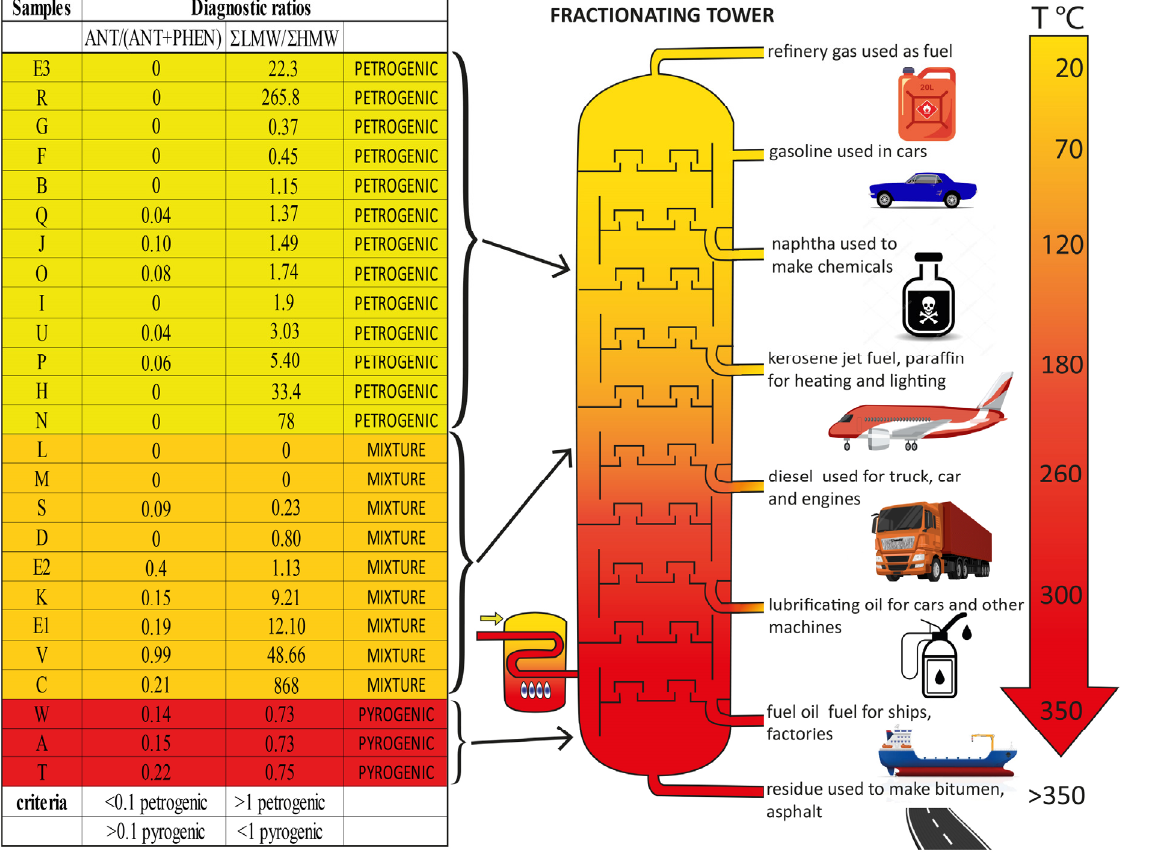
Figure 2. Fractionating tower of different petroleum products. On the left, a table shows, according to the samples, the petrogenic or pyrogenic ratio of the mixture found in the petroleum residues in formulants of pesticides in this study. The origin in the fractionating tower is indicated on the right, highlighting that the ratio can give different origins of PAHs.